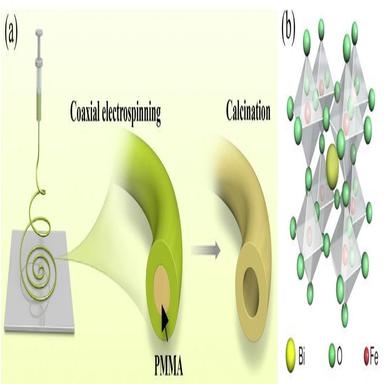
(a) Schematic fabrication process, (b) crystal unit cell structure, of the BFO.